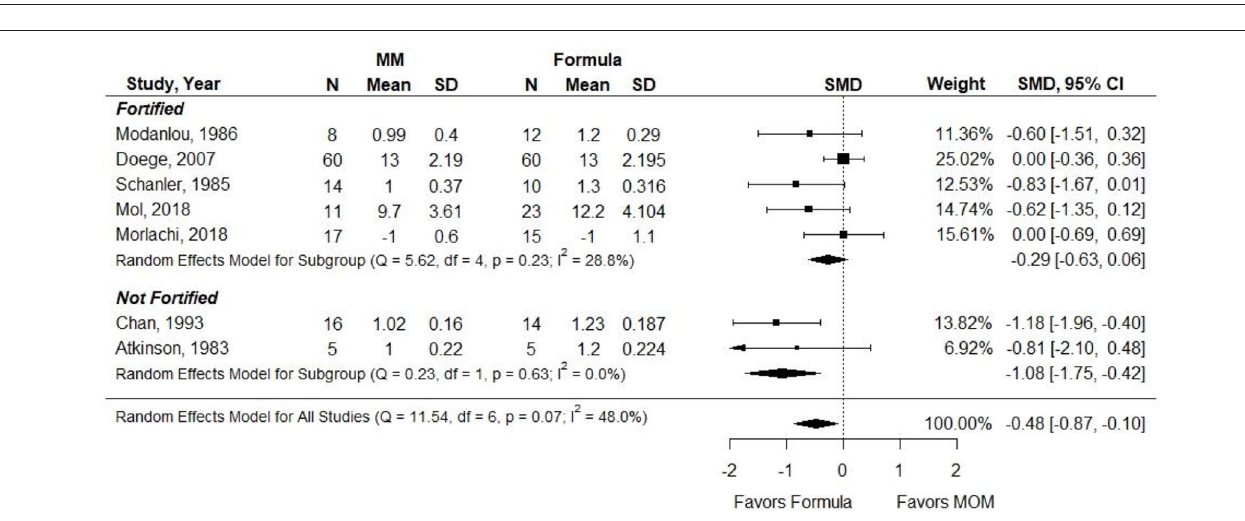
FIGURE 6 | Forest plot demonstrating SMD (95%CI) of length gain for VLBW preterm infants receiving ≥ 75% intake from Maternal Milk (MM) compared to exclusive formula